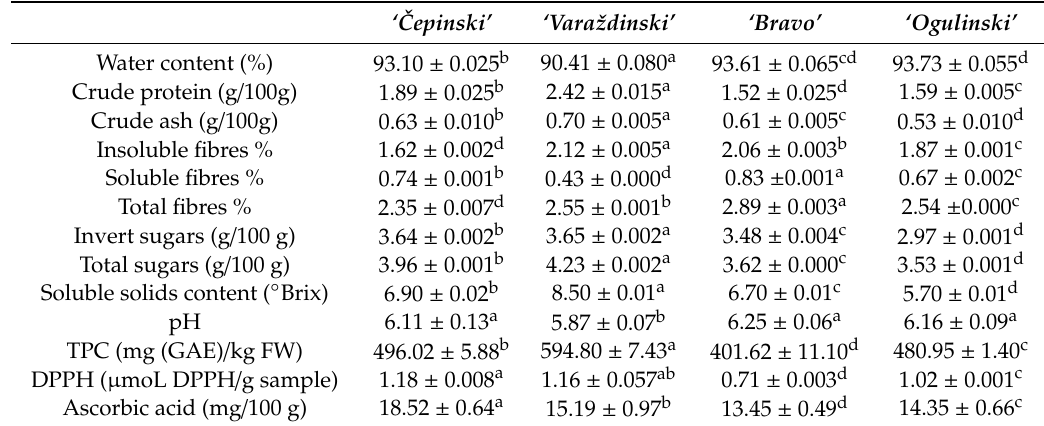
Table 2. Chemical properties of cabbage cultivars ( ‘ ˇCepinski’ , ‘Varaždinski’ , ‘Bravo’ , ‘Ogulinski’